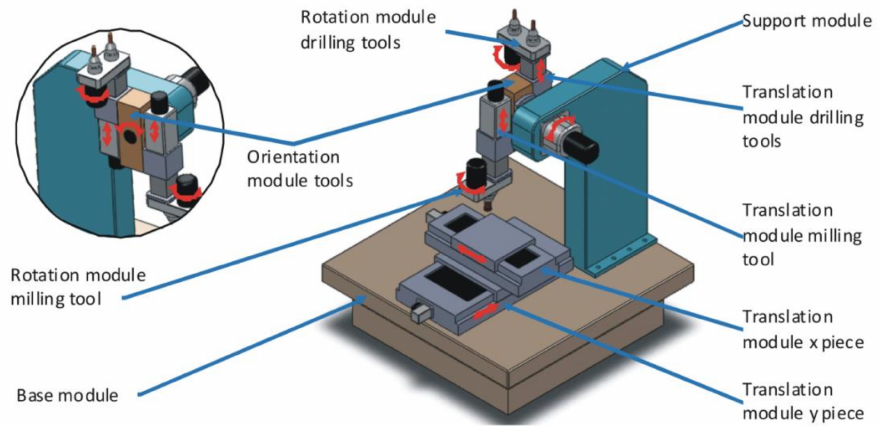
Figure 10. Particle 2 at iteration 4: variant